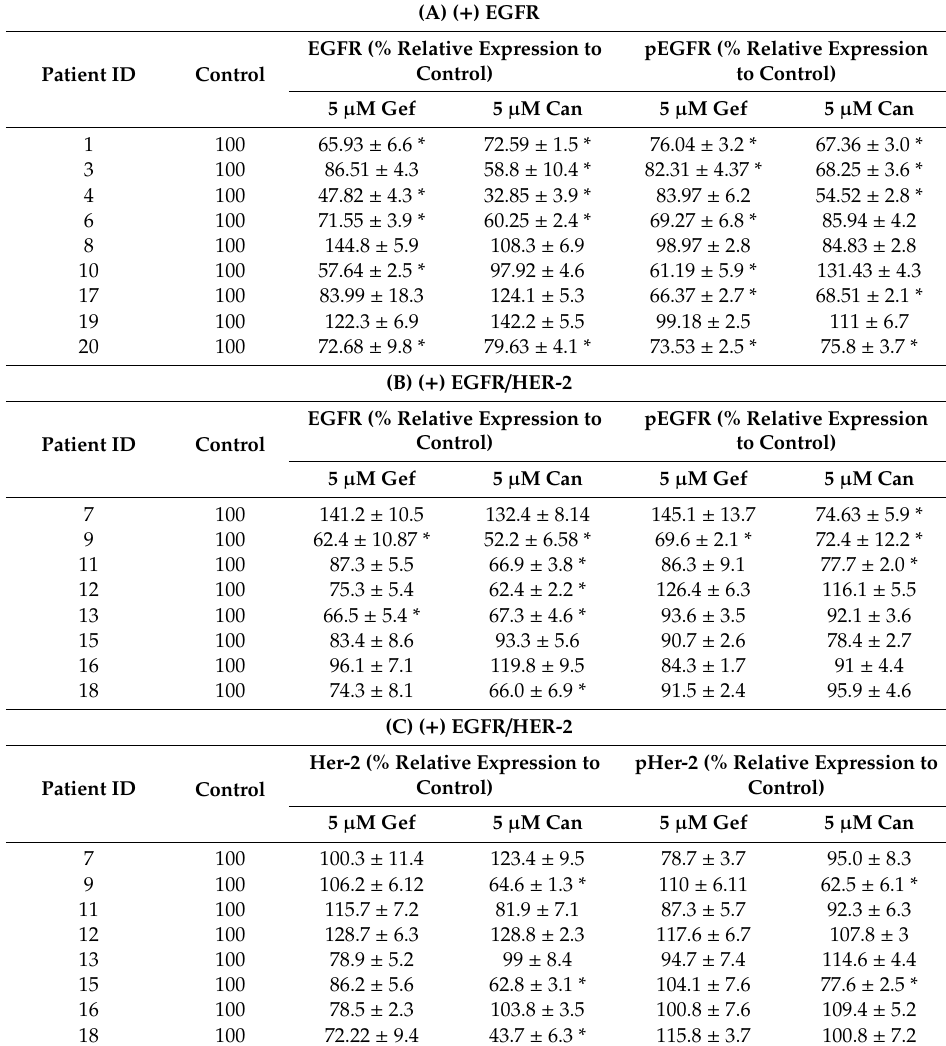
Table 4. The protein level and phosphorylation of EGFR and HER-2 in ascitic fluid derived cells that are exposed to gefitinib (Gef) and canertinib (Can). Gef and Can demonstrate the selective decrease in EGFR and pEGFR in ascitic fluid EGFR positive cells ( A ). Similarly, ascitic fluid derived cells with EGFR / HER-2 positive cells respond to Gef and Can randomly reduce EGFR, pEGFR, HER-2 and pHER-2 ( B , C ). Expressions of EGFR, pEGFR, HER-2 and pHER-2 were obtained from the fluorescent intensity of immunofluorescent staining of corresponding proteins. The fluorescent intensity was calculated from at least five cell clusters and aggregates from cells that were prepared by frozen sections. The fluorescent intensity of the control is normalised to 100 percent and the fluorescent intensity of treatment is calculated relatively to the control sample. Representative analysis is presented from a set of two independent experiments; each experiment had at least three duplicates (Mean ± SE; n = 2) and statistical significance was determined by a t -test ( * , p < 0.05).